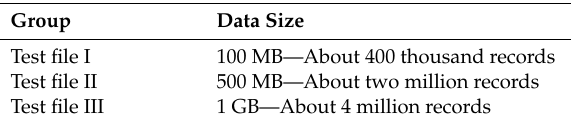
Table 1. Test files.